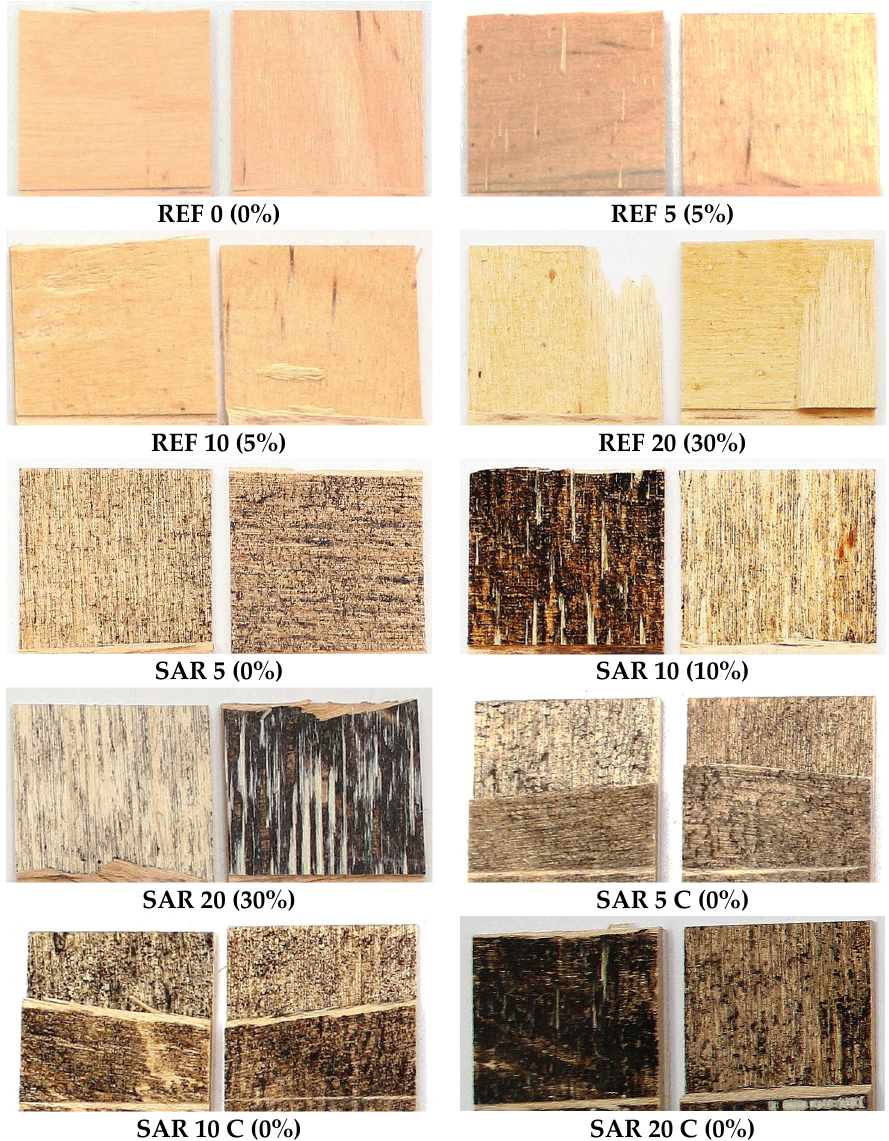
Figure 4. The images of the break zones of the samples after the shear strength test (dimensions: 25 × 25 mm 2 ; numbers in brackets are the estimation of in-wood damage).